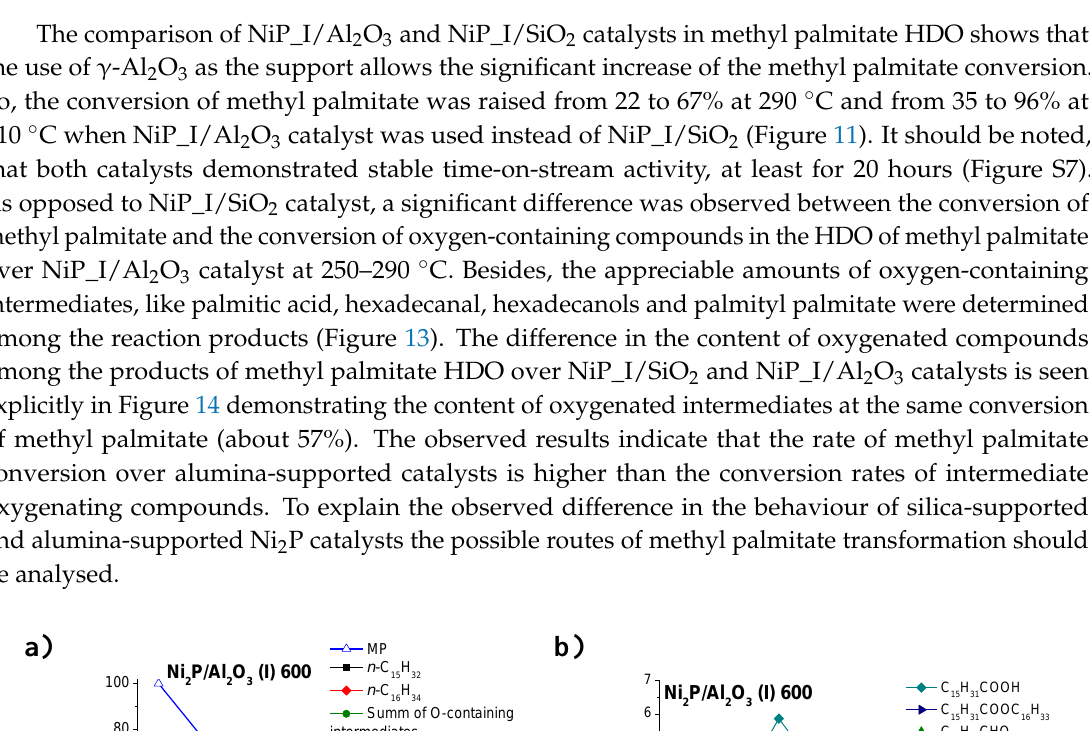
Figure 12. Concentration profiles of the liquid-phase components during methyl palmitate HDO over NiP_I/SiO 2 (600) catalyst: ( a ) MP, C 15 and C 16 hydrocarbons and sum of oxygen-containing intermediates; ( b ) the observed intermediates (P H2 = 3.0 MPa, T = 290 °C, H 2 /feed = 600 Nm 3 /m 3 , contact time = 0.83–3.75 min).